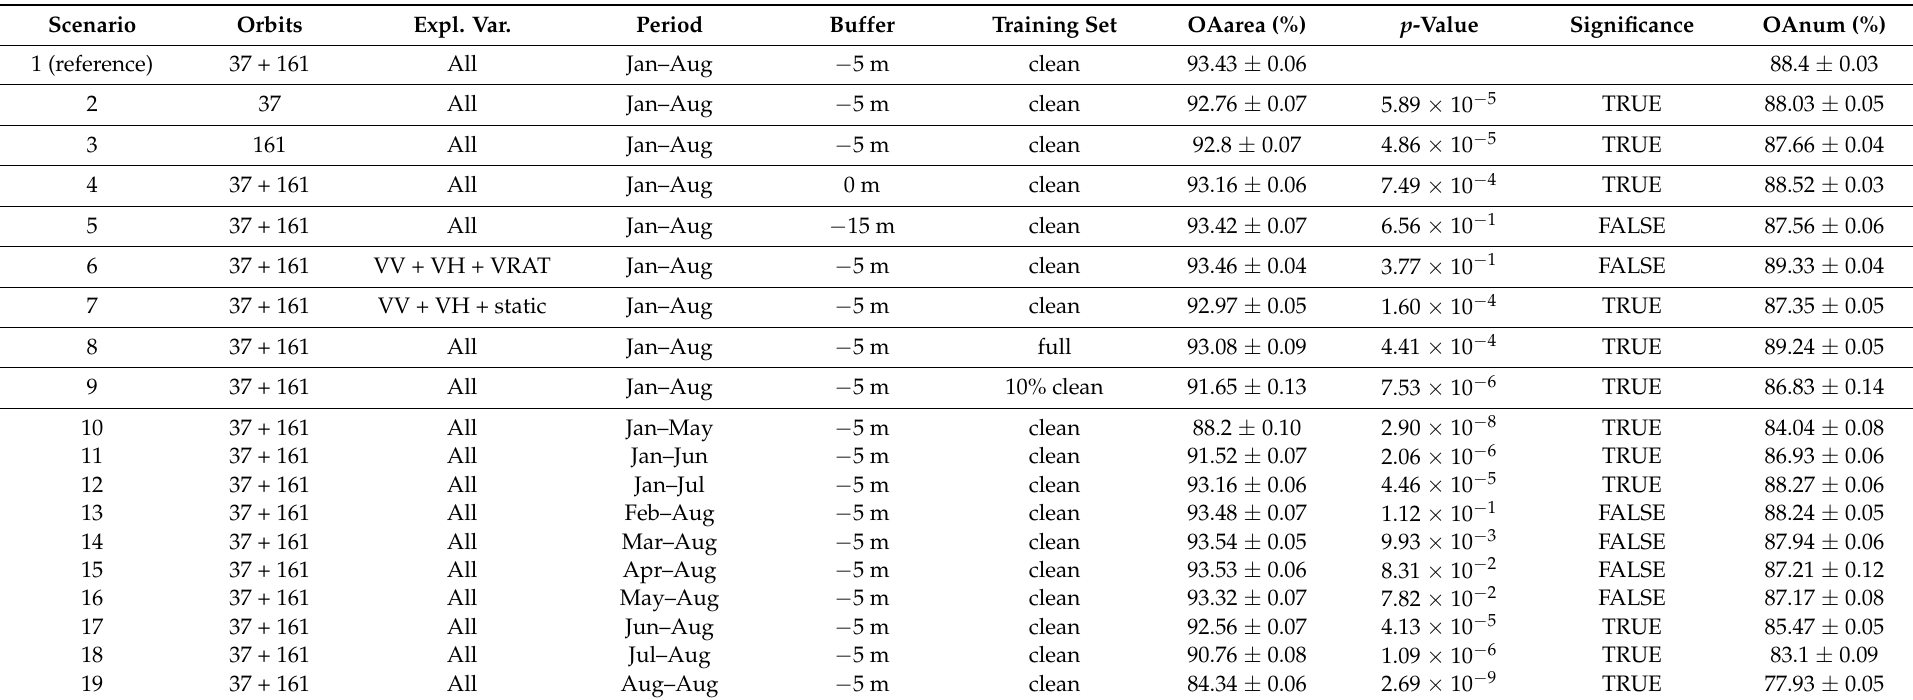
Table 4. Results of the classifications using different SAR datasets, different sizes for the internal buffer applied to the parcels geometry, different sets of explanatory variables, different numbers of parcels in the training set, and different periods of SAR data acquisition. (The significance includes a Bonferroni